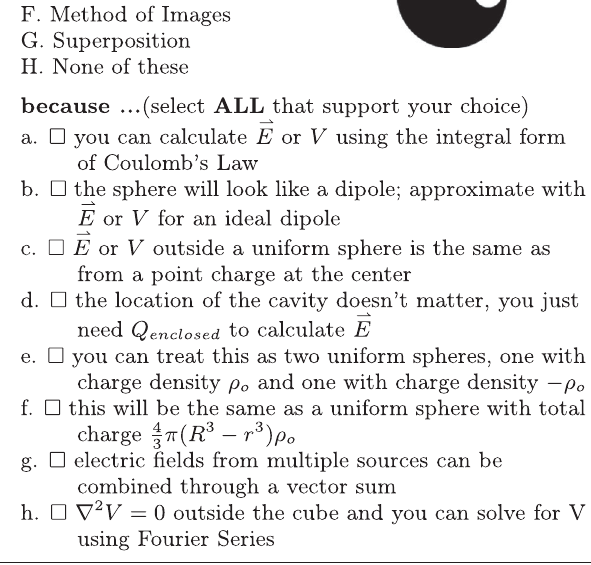
FIG. 1. A sample item from the CMR CUE. The prompt has been paraphrased; see Ref. [8] for the full prompt and a detailed discussion of question development and